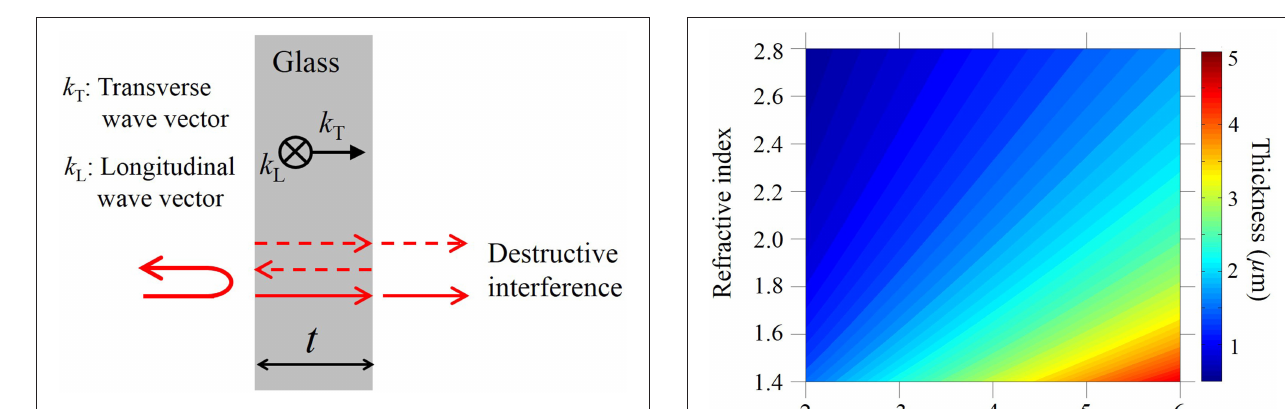
FIGURE 2 | Schematic illustration of the antiresonance condition.